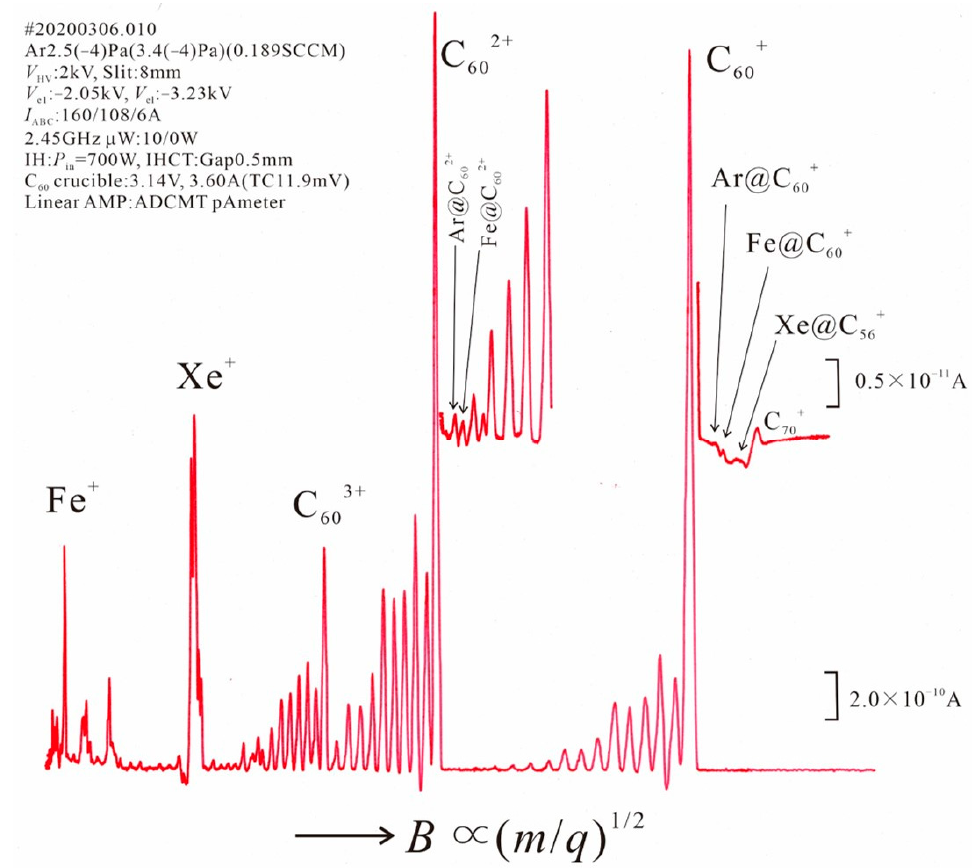
Figure 4. Typical spectrum on the high mass side of the C 60+ and C 602+ spectra (linear amplifier).